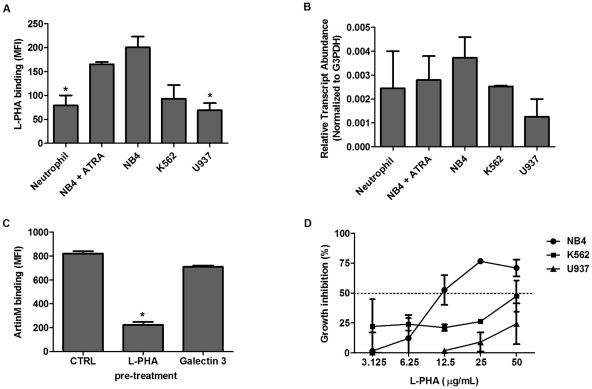
β1-6GlNAc branched N-glycans as targets for lectin recognition and cell growth inhibition.
A) Binding of β1-6GlNAc by lectin L-PHA in leukemia cell lines: NB4, K562, and U937 cells were incubated with L-PHA-FITC for 30 min (5 µg/mL). Blood neutrophils from healthy donors and NB4 cells pretreated with ATRA were also assayed. Lectin binding was detected by flow cytometry and expressed as mean fluorescence intensity (MFI). B) GnT-V mRNA levels in myeloid cell lines: NB4, K562, and U937 cells, as well as blood neutrophils from healthy donors (CD11b+) and NB4 pretreated with ATRA (1 µM, 48 h) were assayed. Average Ct values from triplicate samples obtained for each gene, with a standard deviation of less than 0.5 Ct units, were converted to linear values and normalized to the housekeeping gene G3PDH. C) L-PHA, but not galectin-3, competes for the ArtinM target on NB4 cells: NB4 cells were incubated with L-PHA or Galectin-3 (5 µg/mL) and then assayed for ArtinM binding (see figure 1). ArtinM binding was detected by flow cytometry and expressed as mean fluorescence intensity (MFI). D) Inhibition of leukemia cell growth by L-PHA: NB4, K562, and U937 cells were cultured for 48 h in the presence or absence of 3.125–50 µg/mL L-PHA. Cell growth was evaluated by MTT assay. The curves show the inhibition of cell growth by L-PHA relative to the growth of untreated cells. Each point was obtained from a triplicate assay. The dotted line indicates the L-PHA concentration necessary to inhibit growth by 50% (IC50). The result shown are representative of 3 independent experiments and are expressed as mean ± SD, *p<0.05 (Tukey's test).